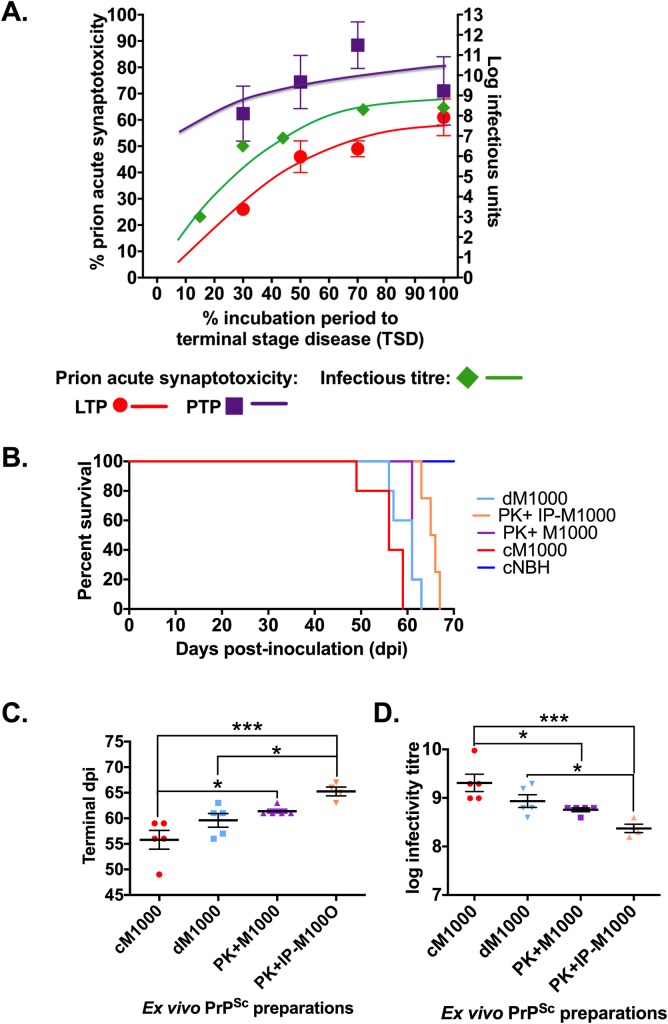
Evidence for efficiently transmitting minimally synaptotoxic PrPSc species co-existing with separate primarily synaptotoxic species at terminal disease stage.(A) Concomitant representation of the degree of prion acute synaptotoxicity across the disease progression calculated as the percentage of LTP and PTP decline from normal LTP together with titre of infectivity (log ID50 units/g brain) across the designated time points as published previously [8]. (B) Kaplan-Meier survival curves of tga20 mice intracerebrally (ic) inoculated with various 1% (w/v) preparations generated from brains of terminally sick M1000 inoculated WT mice, including crude M1000 brain homogenates (cM1000), PrP-immuno-depleted cM1000 (dM1000), 5μg/ml proteinase-K (PK) digested cM1000 (PK+M1000), and reconstituted PK-eluted immuno-precipitated PrP (PK+IP-M1000), as well as tga20 mice sham inoculated with crude NBH (cNBH). (C) Comparison of the average survival (day post-inoculation; dpi) to the TSD in tga20 mice ic inoculated with cM1000, dM1000, PK+M1000, and PK+IP-M1000 (One-way ANOVA with Tukey’s correction for multiple comparisons). (D) Comparison of the estimated mean infectivity titres (log10 ID50 units/g brain) of the cM1000, dM1000, PK+M1000, and PK+IP-M1000 preparations (One-way ANOVA with Tukey’s correction for multiple comparisons). The mean time to the TSD was used to calculate the approximate infectivity titre of each M1000 preparation using a linear regression formula obtained from previous quantal dose titration of M1000 prion infectivity in tga20 mice [8]. Data are presented as mean ± standard error of mean. *p<0.05, ***p<0.001.